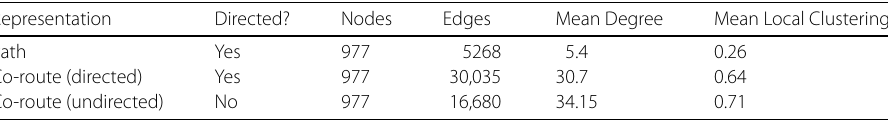
Table 2 Statistics for each graphical representation of the service route data. The path graph is substantially more sparse than the other two representations Representation Directed? Nodes Edges Mean Degree Mean Local Clustering Path Yes 977 5268 5.4 0.26 Co-route (directed) Yes 977 30,035 30.7 0.64 Co-route (undirected) No 977 16,680 34.15